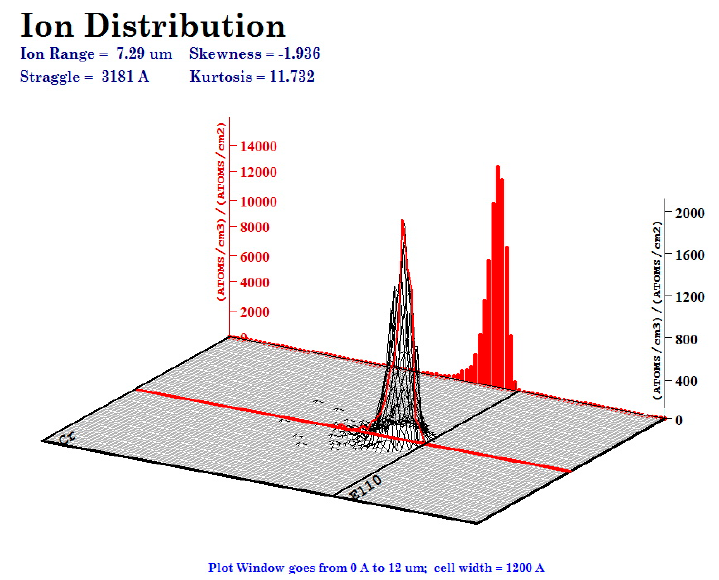
Figure 6. Ion range for 120 MeV Tc in E110 alloy, coated with 8 µm Cr thin film.